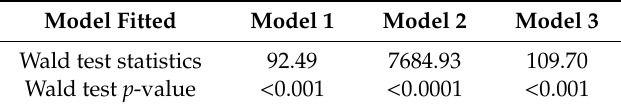
Table 4. Model fit test’s